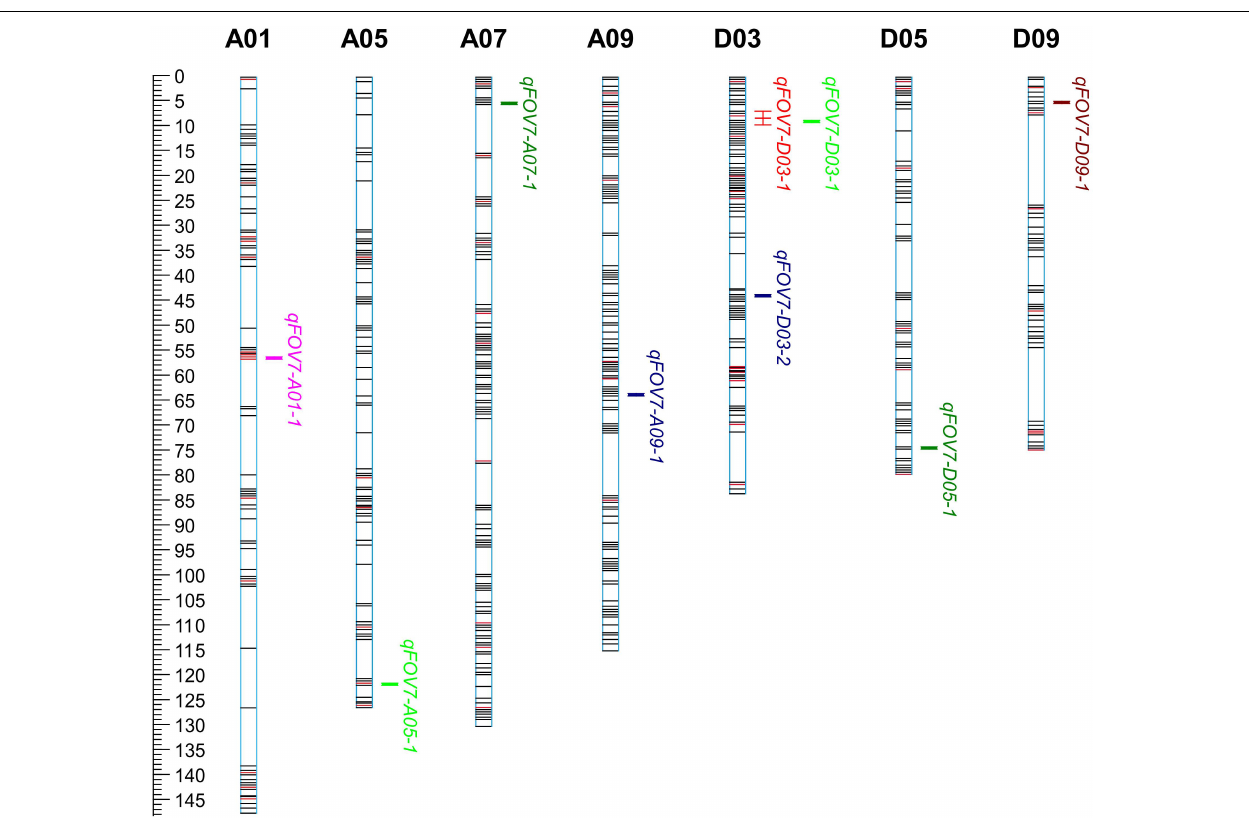
FIGURE 3 | The chromosome distribution of QTLs for FOV7 resistance in a RIL population of Gossypium barbadense .